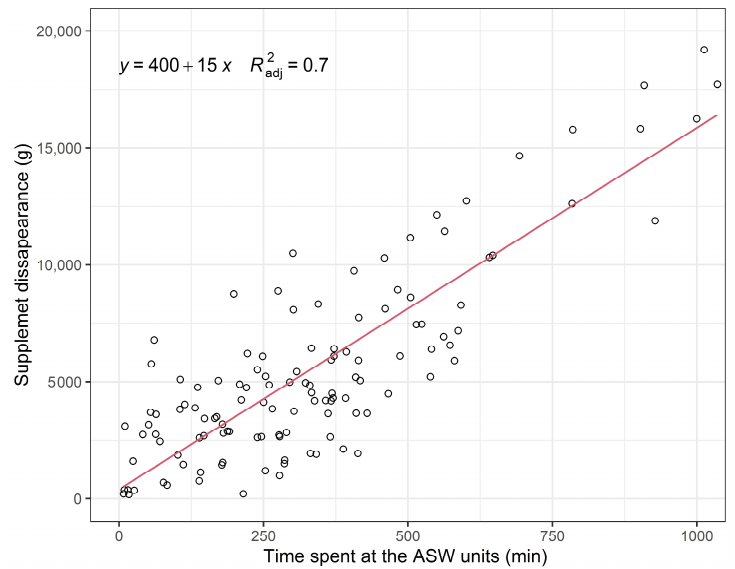
Figure 7. Relationship between mineral block supplement disappearance and time spent at the automatic supplement weighing (ASW) units by the herd across two sites over 62 days of data collection. The regression line shows a trend.